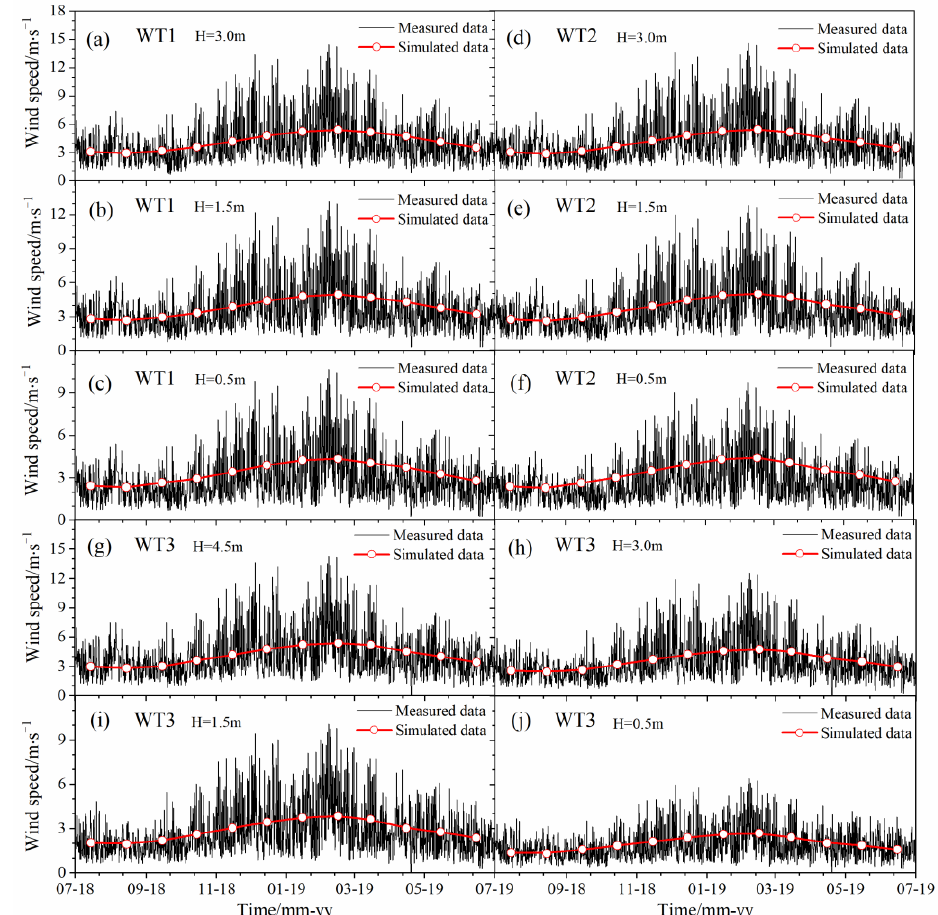
Figure 7. Comparisons between the measured and simulated wind speeds at different heights of the three wind-towers: ( a – c ) WT1 with the heights of 0.5, 1.5, and 3.0 m above the ground; ( d – f ) WT2 with the heights of 0.5, 1.5, and 3.0 m above the ground; and ( g – j ) WT3 with the heights of 0.5, 1.5, 3.0, and 4.5 m above the ground.